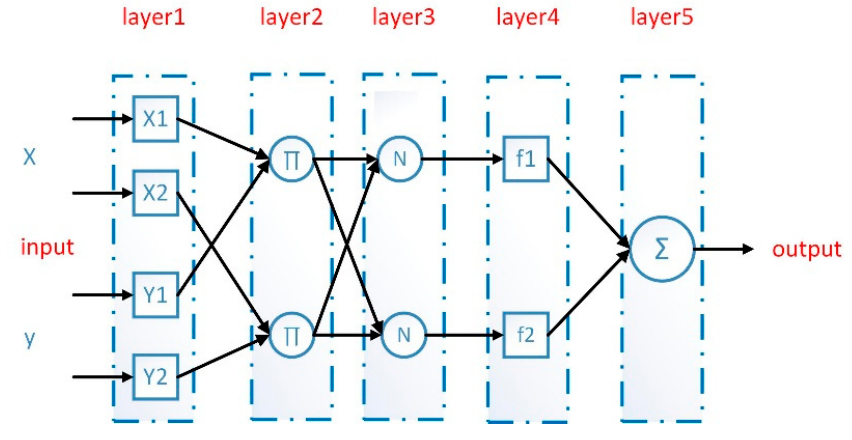
Figure 5. A block diagram of the ANFIS model [25].